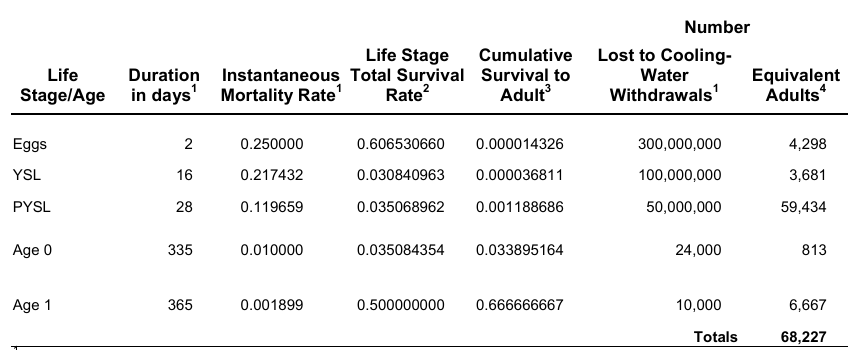
Example of the EAM for Queenfish Based on Entrainment and Impingement Losses at a Hypothetical Power